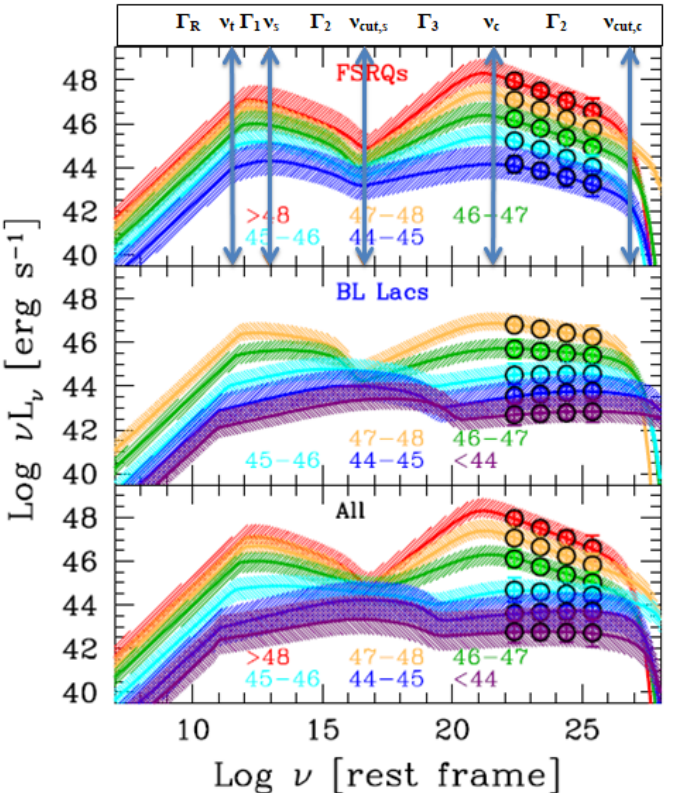
Figure 2. Spectral parameters of the two-hump multi-wavelength spectra for the new phenomeno- logical Fermi blazar sequence, substantiated in [4]. Upper, middle and lower parts of the figure show the spectra of FSRQs, BL Lacs, and all sources, correspondingly. Different colours indicate different bins of the log ( L γ / erg s − 1 ) . Characteristic frequencies and photon indices are presented for FSRQs case with 44 < log ( L γ / erg s − 1 ) < 45. See detail in the text. Figure taken from [4].